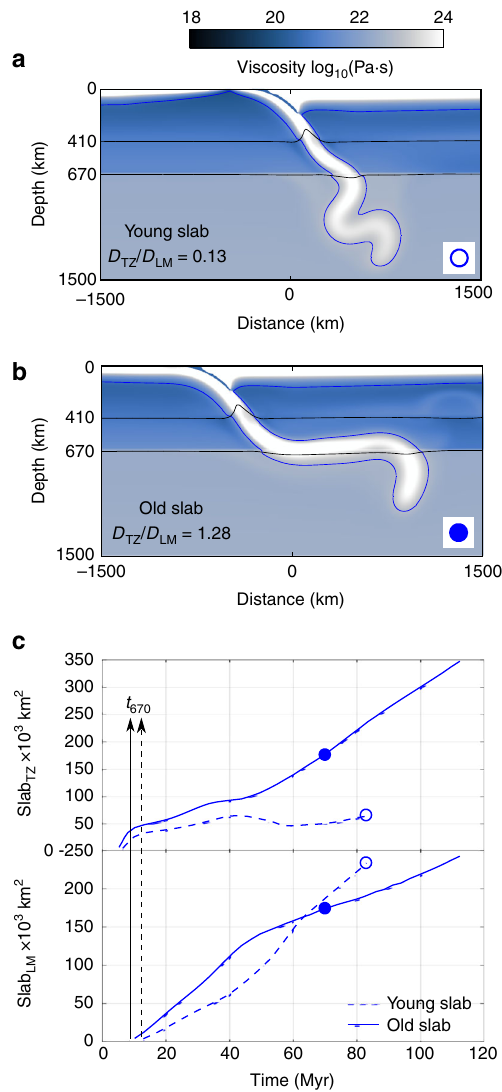
Fig. 2 Slab dynamics for present-day mantle temperature. Cases shown are a young penetrating slab (Simulation 11, open blue circle) ( a ) and old fl attened slab (Simulation 12, solid blue circle, see Supplementary Table 1) ( b ). The initial trench is located at x = 0 km. The blue line is the contour delimiting the slab at constant potential temperature of 1300 °C. For both cases the value of the slab accumulation rate D TZ / D LM is indicated. c Evolution of the volume of slab material in transition zone (Slab TZ ) and lower mantle (Slab LM ). The dots mark the time of the snapshots in a , b . Although signi fi cant volumes of the old slab (solid lines) accumulate in the transition zone, most of the young slab material (dashed lines) goes straight through. The arrows mark the times at which the slabs reach the 670 km depth ( t 670